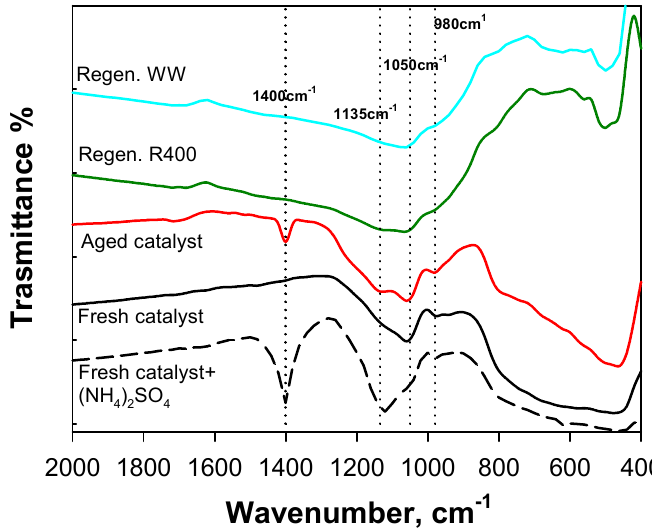
Figure 8. FTIR spectra of the fresh, 18 kh reaction-aged and regenerated (R400 and WW) SCR catalysts as compared to the reference sample of fresh catalyst impregnated with 10 wt% (NH 4 ) 2 SO